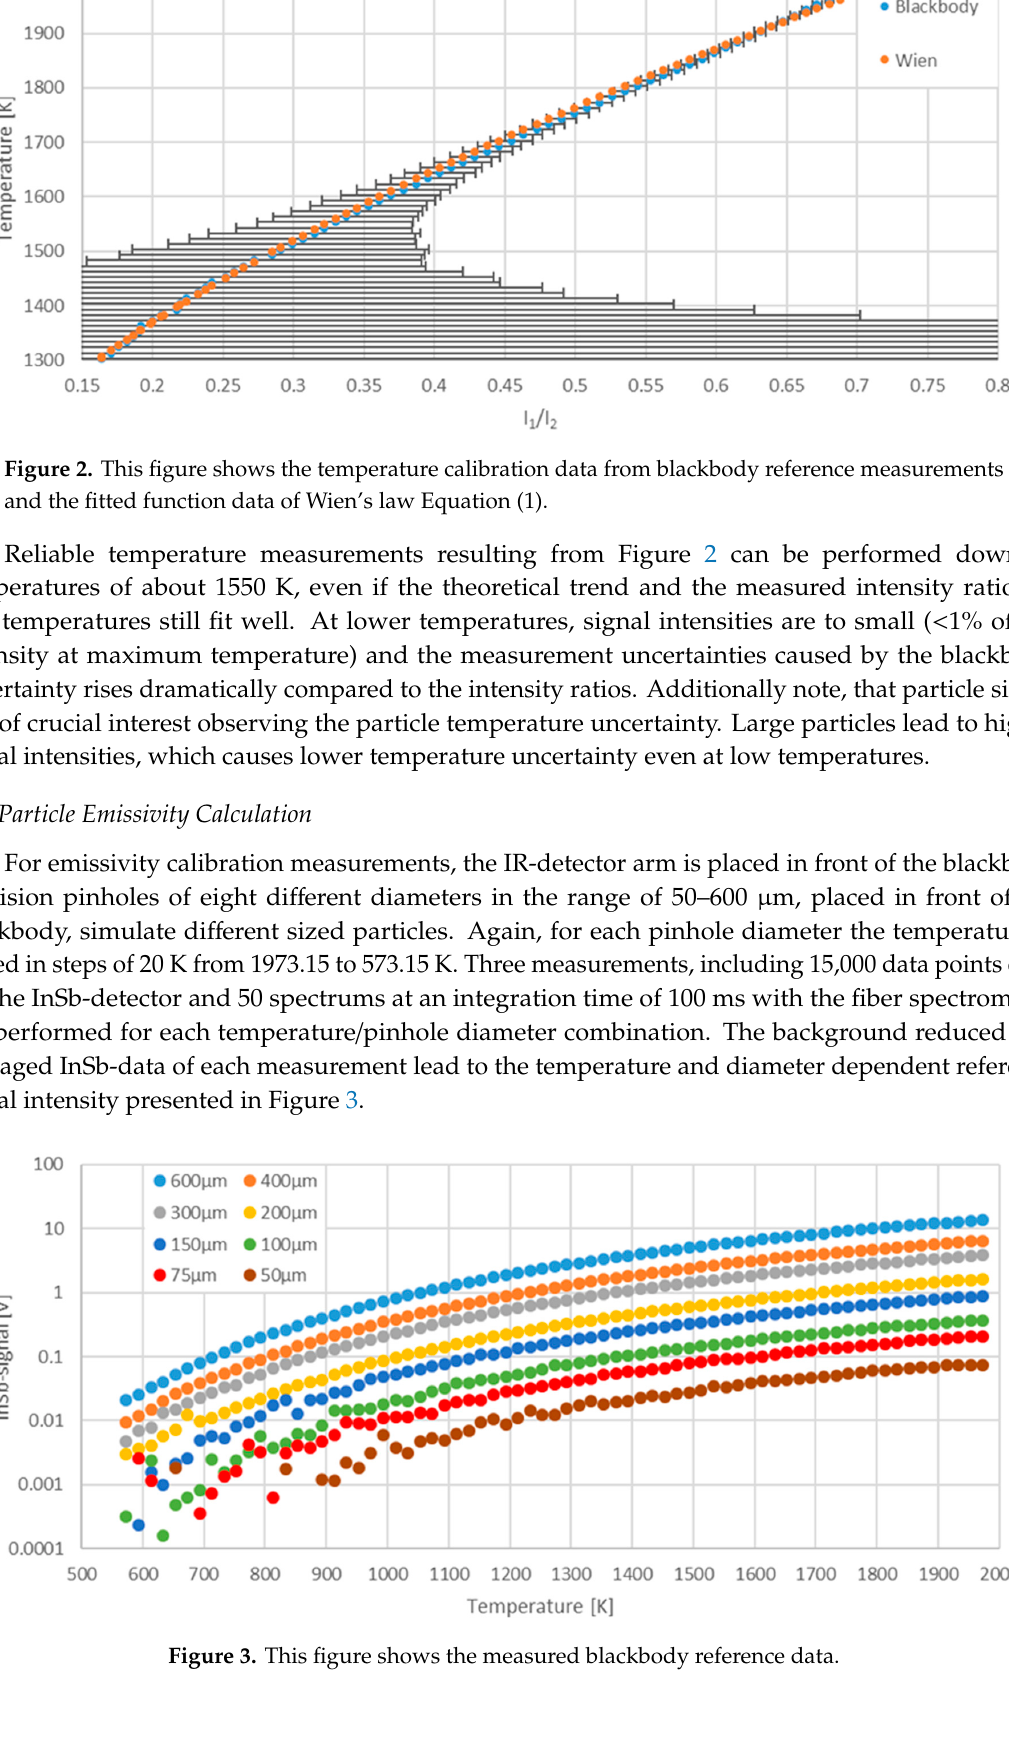
Figure 3. This figure shows the measured blackbody reference